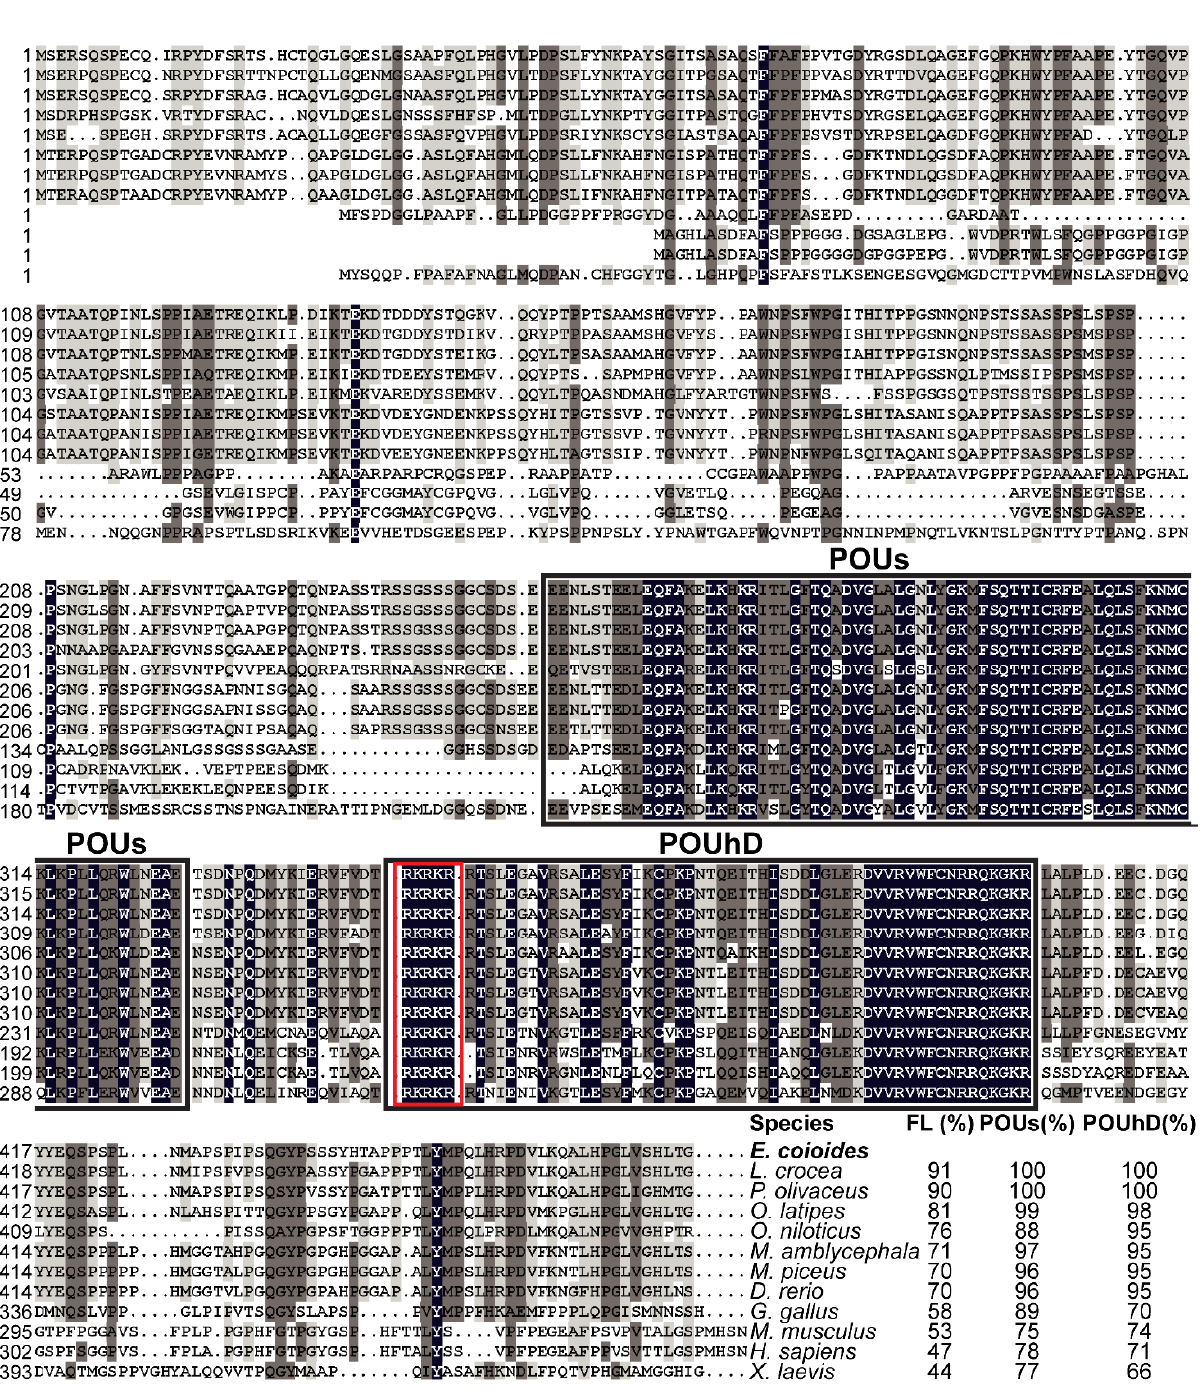
Figure 2. Multiple sequence alignment and comparison of EcPou5f1 with the homologs from other vertebrates. Black shadow: 100% identity; Brown shadow: 75% ≤ identity < 100%; Light brown shadow: 50% ≤ identity < 75%. Large black box: POUs and POUhD domains; Red box: a nuclear localization motif of RKRKR. The percent identity among EcPou5f1 and other Pou5f1 homologs in full-length (FL) and POU domains is displayed at the end of the alignment. The species’ name with a bold font indicates the EcPou5f1 protein of orange-spotted grouper. GenBank accession numbers for Pou5f1 are as follows: E. coioides , OL439940; L. crocea , NP_001290294; P. olivaceus , ALA23412; O. latipes , NP_001098339; Oreochromis niloticus , XP_003444455; M. amblycephala , AVV48156; Mylopha- ryngodon piceus , ATP62009; D. rerio , NP_571187; Gallus gallus , NP_001296301; M. musculus , NP_038661; H. sapiens , NP_002692; and Xenopus laevis , NP_001079832.